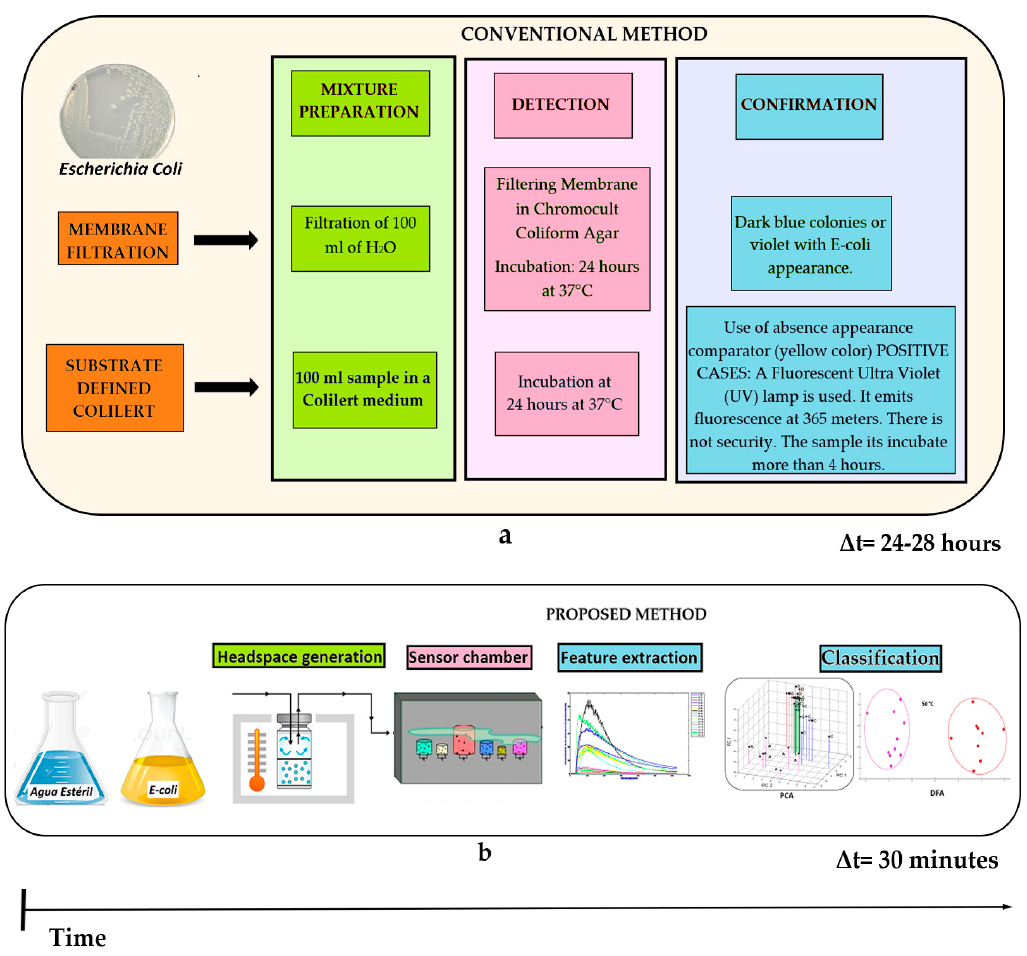
Figure 9. Response time comparison: ( a ) Conventional method and ( b ) proposed method.